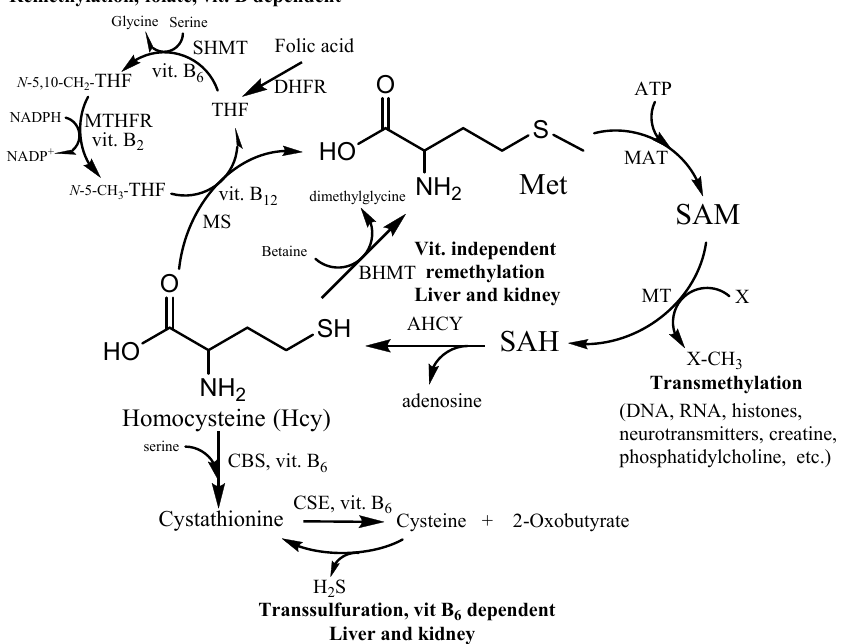
Figure 1. Homocysteine (Hcy) metabolic pathway. SAM— S -adenosylmethionine; SAH— S -adenosyl homocysteine; MS—methionine synthase; BHMT—betaine-homocysteine methyltransferase;